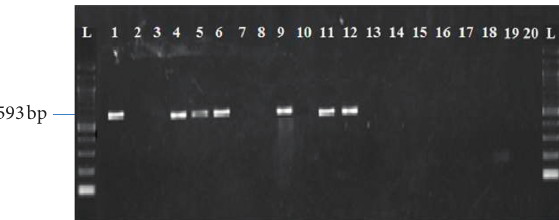
Figure 2: Detection of Cucumber mosaic virus in African nightshade leaves from farm fields in different agroecological zones using RT-PCR. L-DNA ladder. Samples 3, 7, and 11: Suneka; 4, 8, and 12: Ogembo; 5, 9, and 13: Amalemba; 6, 10, and 14: Lurambi; 2: healthy control; 1: positive control. CMV � 593